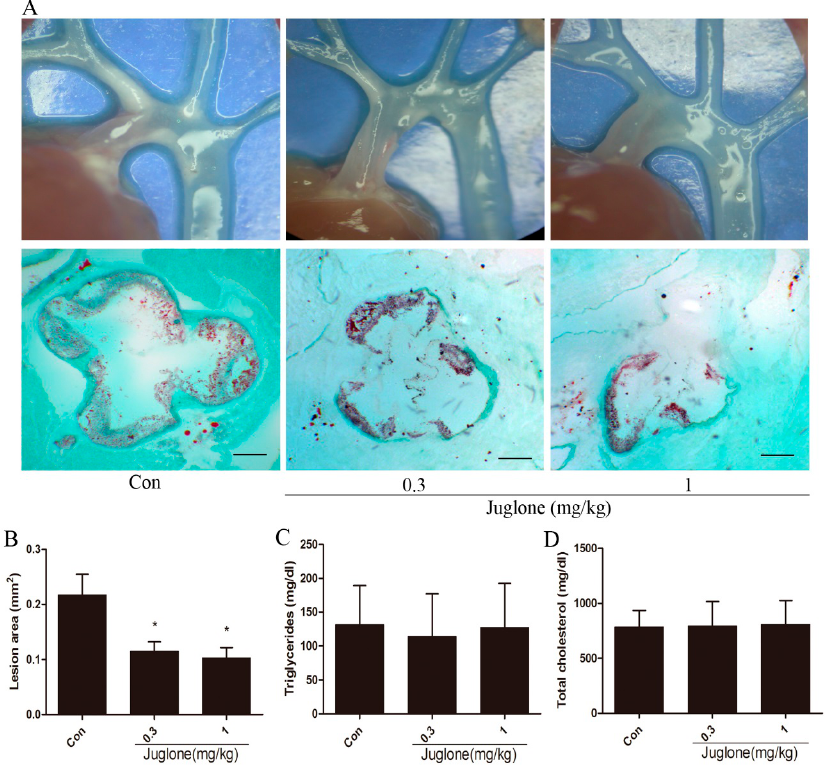
Figure 1. Pin1 impacts atherosclerosis in ApoE − / − mice. After four weeks of respective treatment, 18-week-old ApoE − / − mice were sacrificed. ( A ) Shown were representative pictures of aortic arches (20×) and aortic sinus sections stained with oil red O (Scale bar = 50 μ m); ( B ) Atherosclerotic lesion area in the aortic sinus was quantified ( n = 8). The serum triglyceride ( C ) and total cholesterol ( D ) levels were measured ( n = 6). * p < 0.05 vs. the control group.